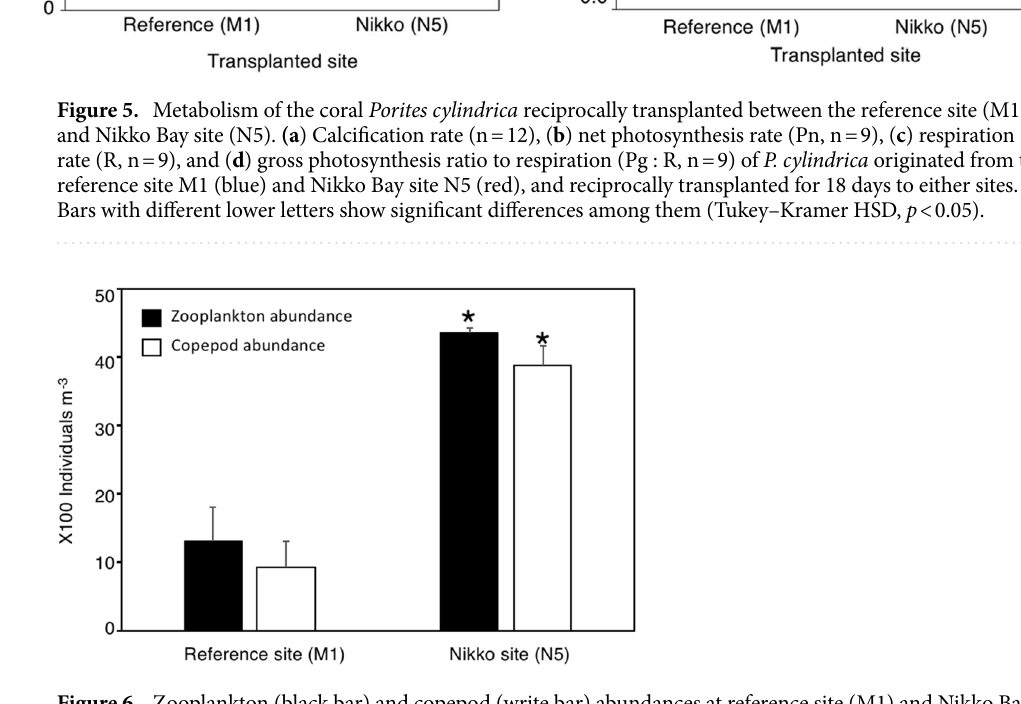
Figure 6. Zooplankton (black bar) and copepod (write bar) abundances at reference site (M1) and Nikko Bay site (N5). Average and S.D. for 3 nights plankton net sampling at each site. Asterisks show significant differences between the two sites (student t -test, p <